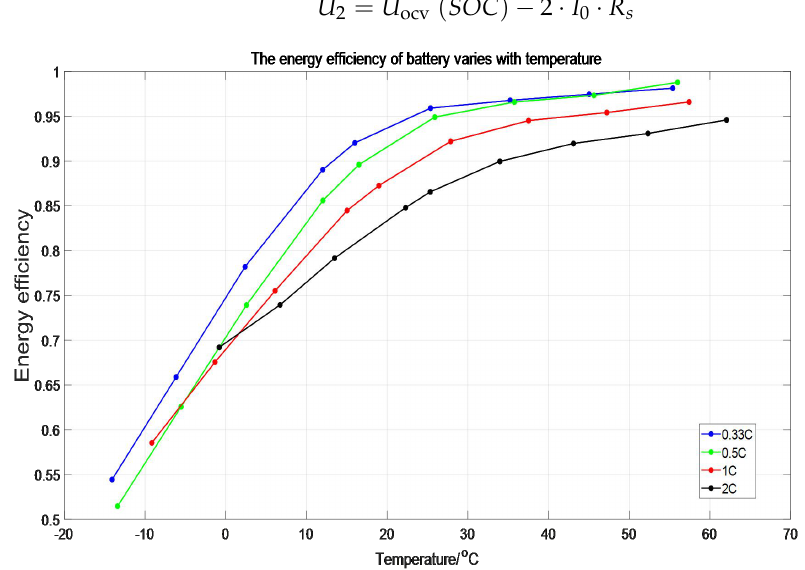
Figure 9. The energy efficiency of the battery varies with the average temperature of the battery shell.